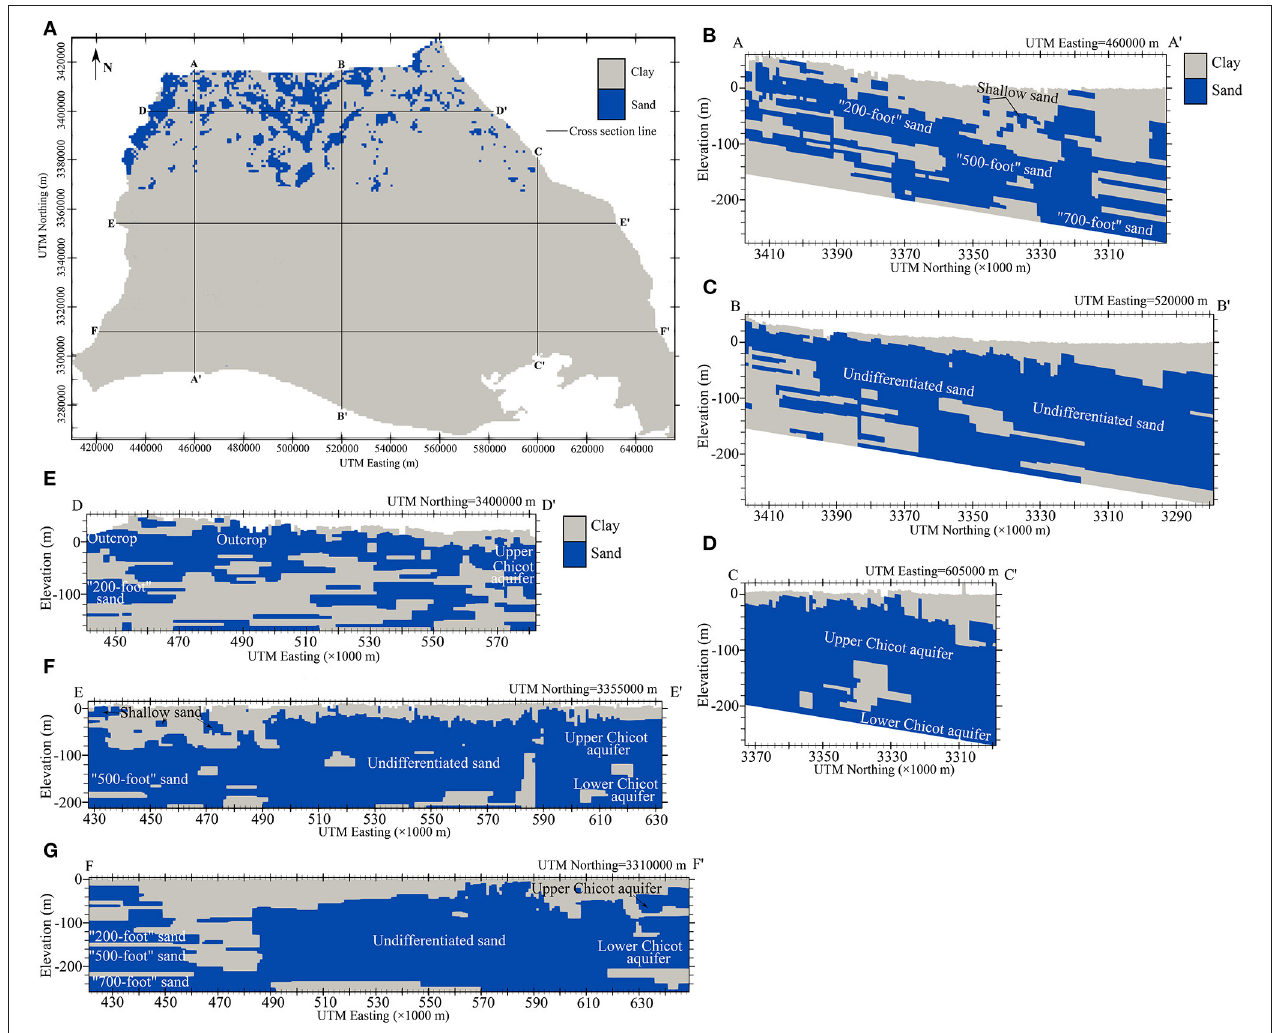
FIGURE 7 | The Chicot stratigraphy model: (A) distributions of surficial sands and surficial clays, (B–D) north-south cross sections, and (E–G) east-west cross sections. The cross sections are magnified 50 times in vertical direction. The vertical datum is NAVD 88.